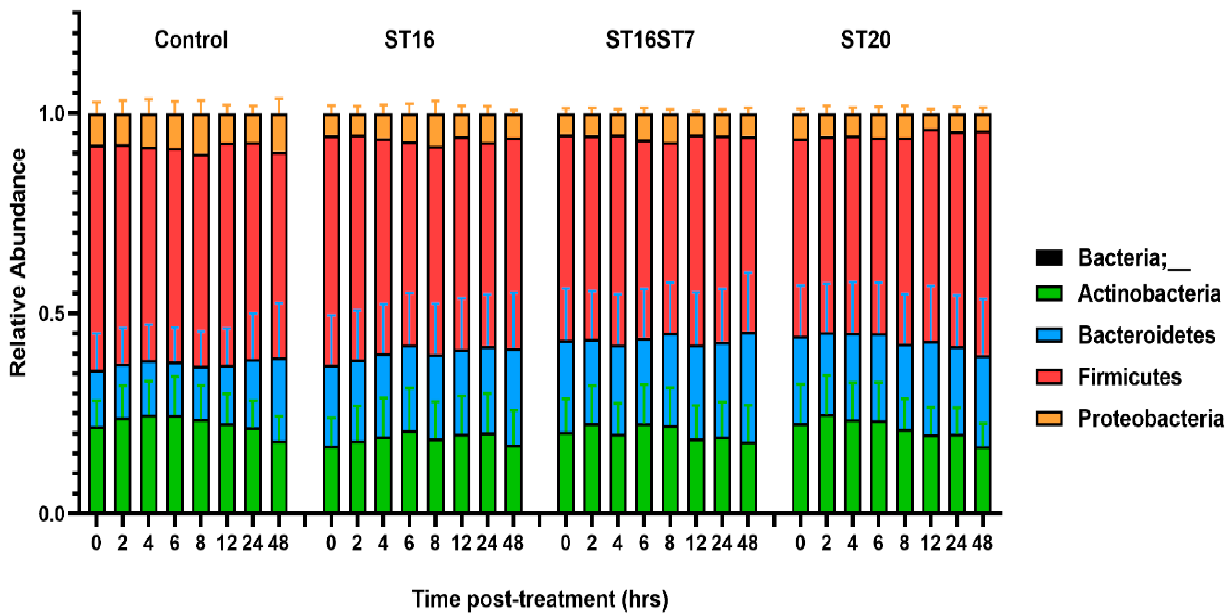
Figure 4. The composition of gut microbiota treated with GABA-active strains over 48 h in the reactor setup of the human colonic ex vivo model. Four bacteria phyla were identified in the generated dataset, including Firmicutes, Bacteroidetes, Proteobacteria, and Actinobacteria.